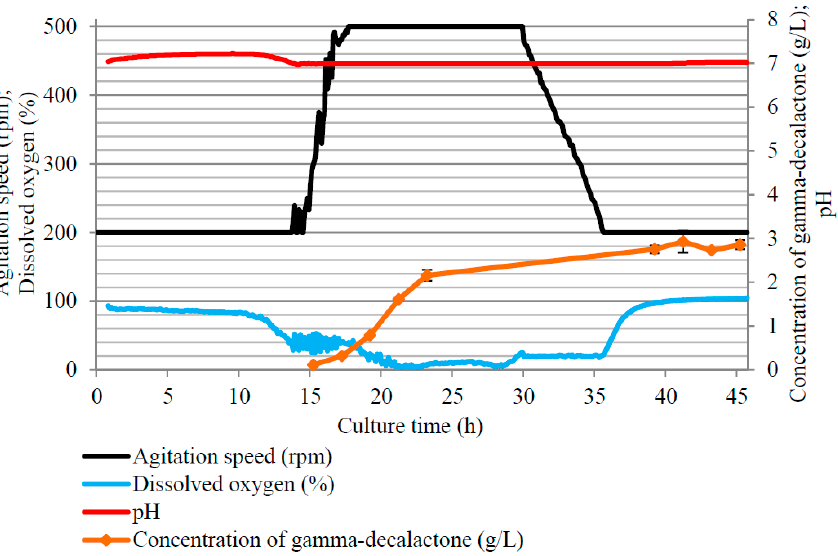
Figure 4. Changes in dissolved oxygen, agitation speed, and concentration of γ -decalactone in the batch culture of Y. lipolytica yeast carried out in accordance with parameters of Table 4 (agitation speed of 200–500 rpm, regulated pH, castor oil concentration of 75 g/L).